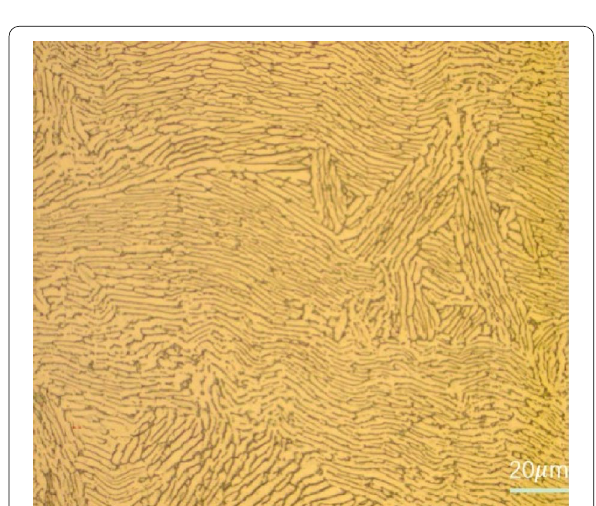
Figure 4 The microstructure image of